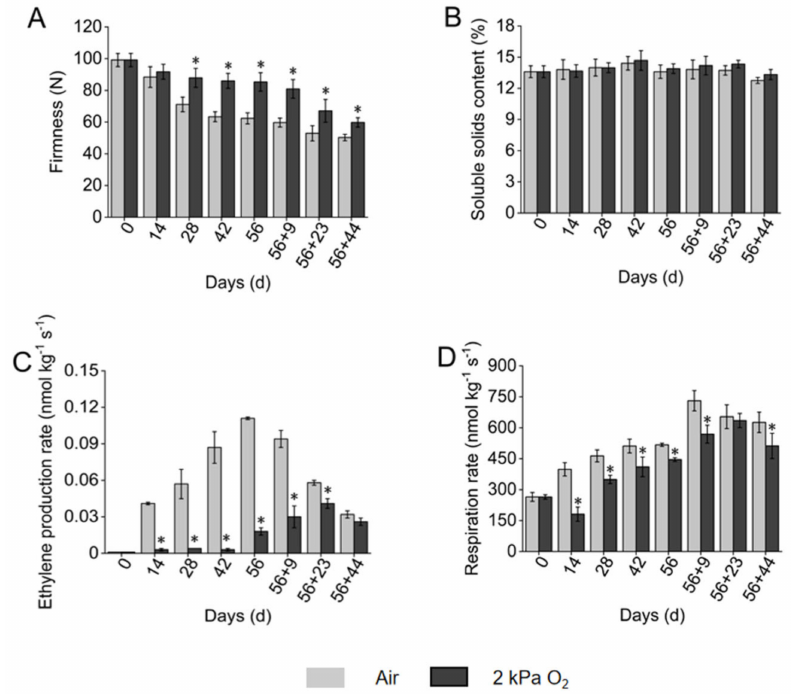
Figure 1. Firmness ( A ), soluble solid content ( B ), ethylene production ( C ) and respiration rate ( D ) of ‘Golden Delicious’ apple fruit during 56-day storage under 2 kPa O 2 + 98 kPa N 2 at 4 ◦ C and subsequent 44-day shelf life at 20 ◦ C. Air represents apple fruit stored in air; 2 kPa O 2 represents apple fruit stored under 2 kPa O 2 + 98 kPa N 2 . Bars indicate standard deviation for each mean value from at least three replicates. Asterisks indicate significant difference between air-stored and 2 kPa O 2 -stored fruit at p < 0.05 (Duncan’s multiple range